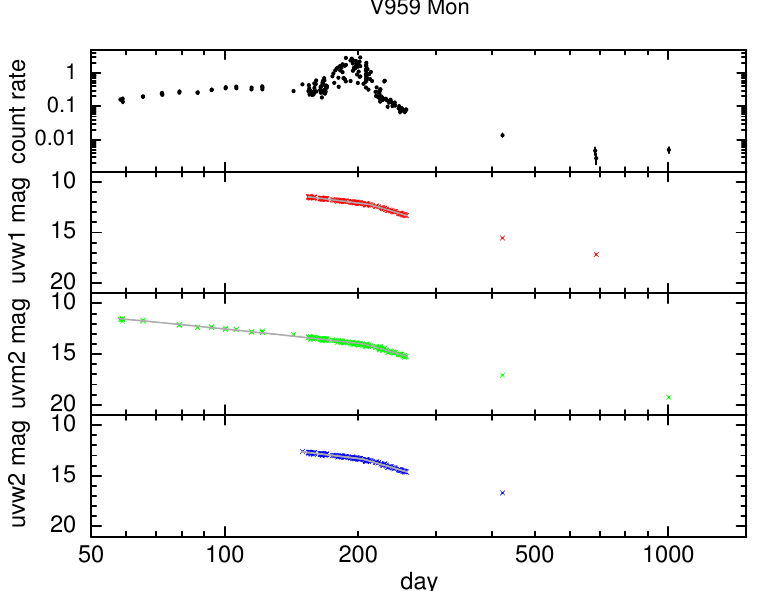
Figure 6. The XRT and UVOT light-curves of V959 Mon, with the best-fit broken power-law declines shown as the grey solid lines. Late-time data beyond day 300 were excluded from the fits, because there are not enough bins to constrain the break times accurately. The observations of V959 Mon are plotted as days since Fermi discovery. The X-ray data (top) are in count s − 1 over 0.3–10